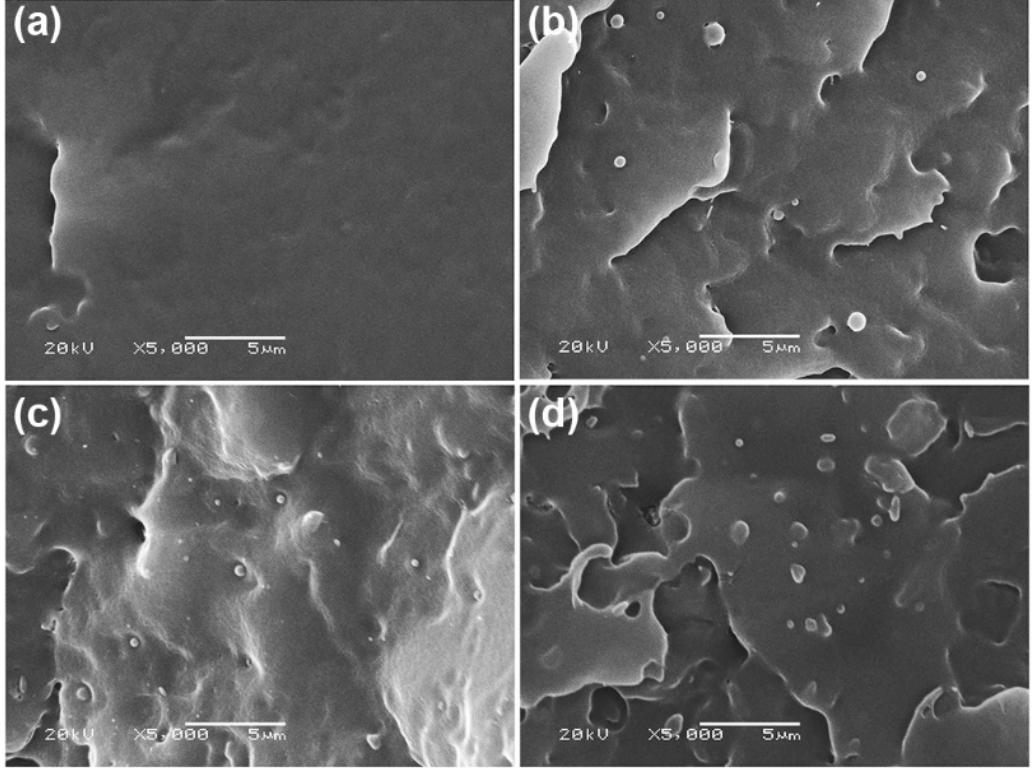
Figure 4. SEM images of cryogenically fractured surfaces of ( a ) pure PLLA3251D film and PLLA3251D/scPLA powder films with scPLA powder contents of ( b ) 2%, ( c ) 4%, and ( d ) 8% w / w (All bar scales = 5 µm).